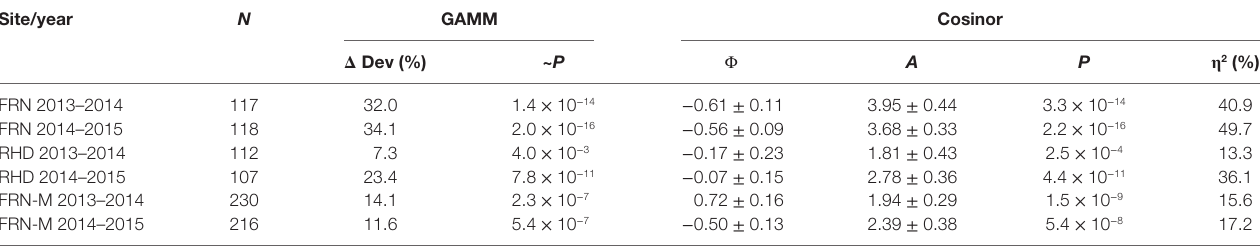
Results for non-parametric smoother time effects in generalized additive mixed models (GAMMs) and for sinusoid time effects in cosinor regression models. For GAMMs, Δ Dev is the reduction in deviance explained by the model, in percentage points, when the time effect is deleted. The approximate P values are based on Wald tests. For cosinor regressions the estimated acrophase ( Ф ) and amplitude (A) parameters are given ± SE, quantifying the timing and magnitude of the sinusoid. The acrophase parameter is the distance (in radians) to the summer peak from the baseline (in September). Also given is the summed classical η 2 effect size for the cosinor (time) terms in the model.